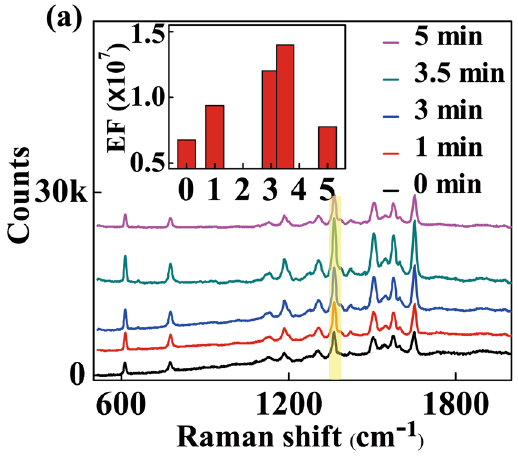
Figure 5. SERS spectra of R6G at a concentration of 1 × 10 − 7 M for GNS4 probe under different acetone treatment time.